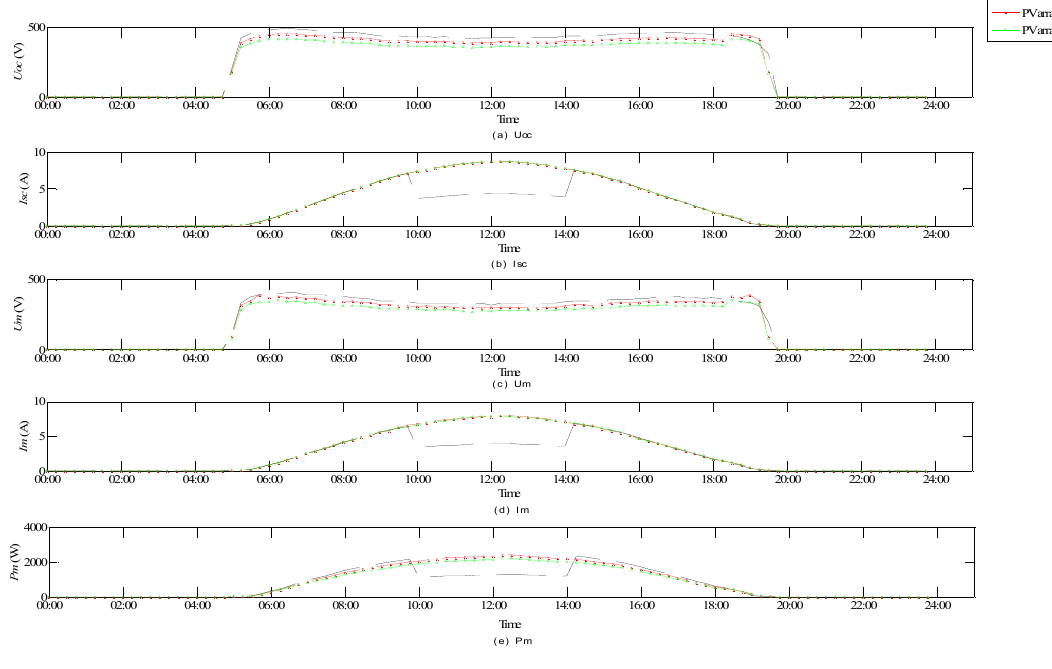
Figure 9. The simulation of transient fault.